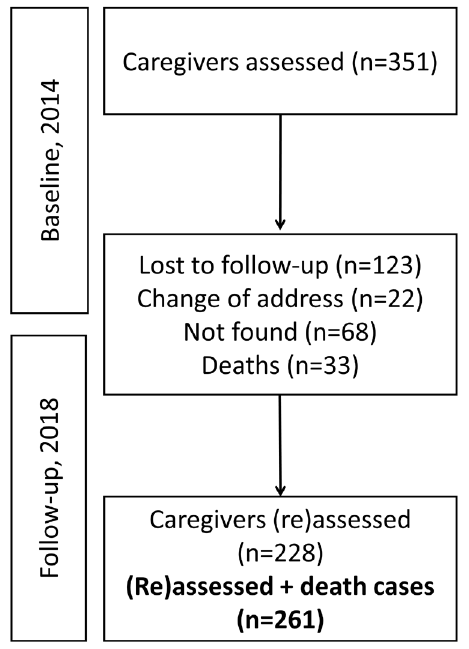
Figure 1. Study participants screening for the longitudinal